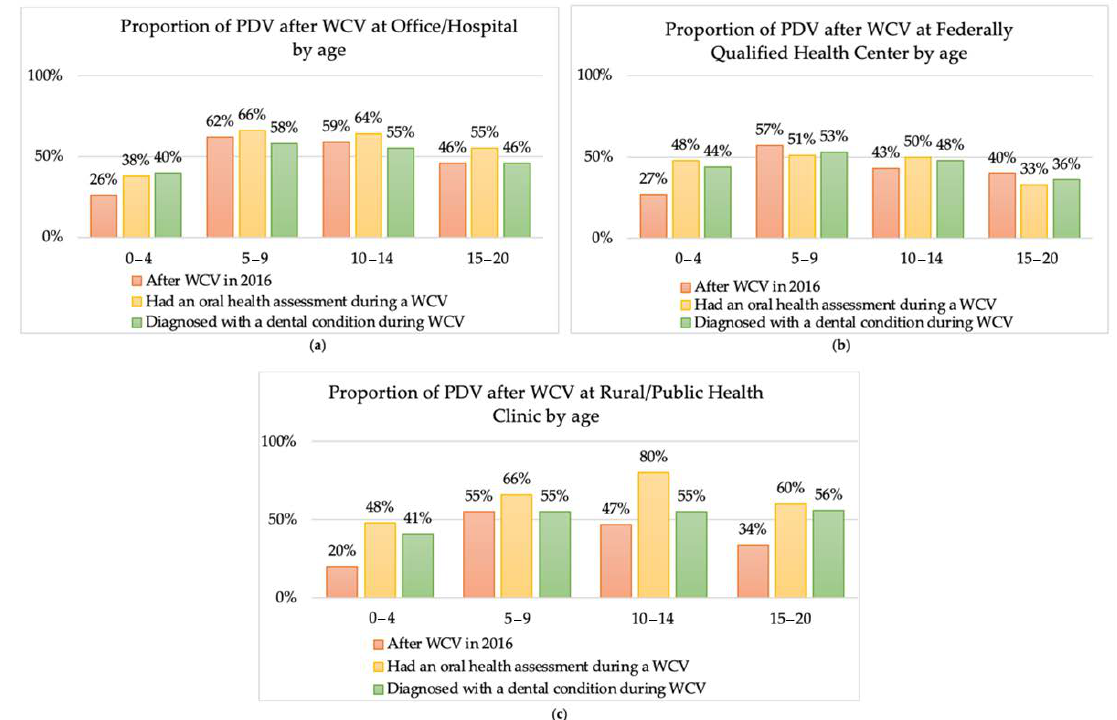
Figure 2. Proportion of children with a preventative dental visit with a prior well-child visit at a rural or public health clinic, with an oral health assessment during a rural or public health clinic WCV, or diagnosed with a dental condition during a rural or public health clinic WCV, by age. ( a ) proportion of PDV after WCV at office/Hospital by age. ( b ) proportion of PDV after WCV at Federally Qualified Health Center by age. ( c ) proportion of PDV after WCV at Rural Public Health Clinic by